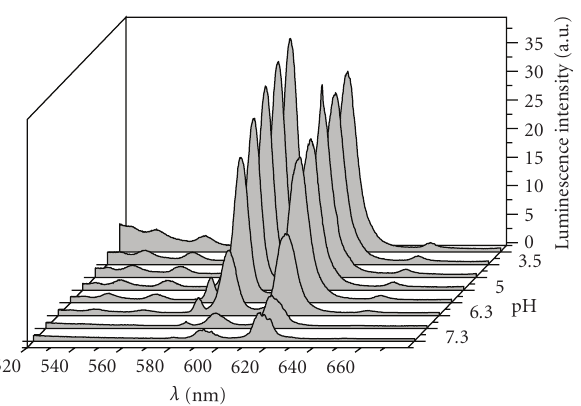
Figure 5: ECL spectra of system containing K 2 S 2 O 8 (2 × 10 − 2 mol × dm − 3 ). (a) and K × 10 − 2 mol × dm − 3 2 S 2 O 8 + Eu 2 (SO 4 ) 3 (5